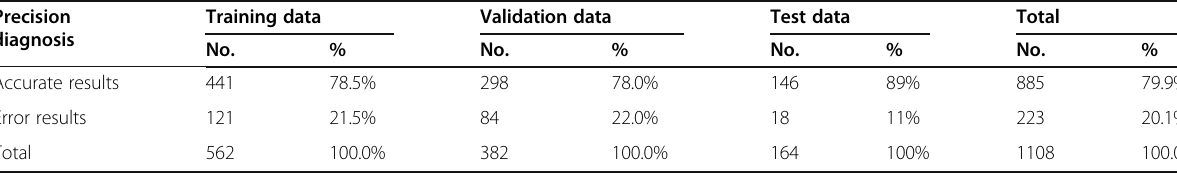
Table 3 The comparison of Precision error rates between the training and validation dataset of TUO Precision